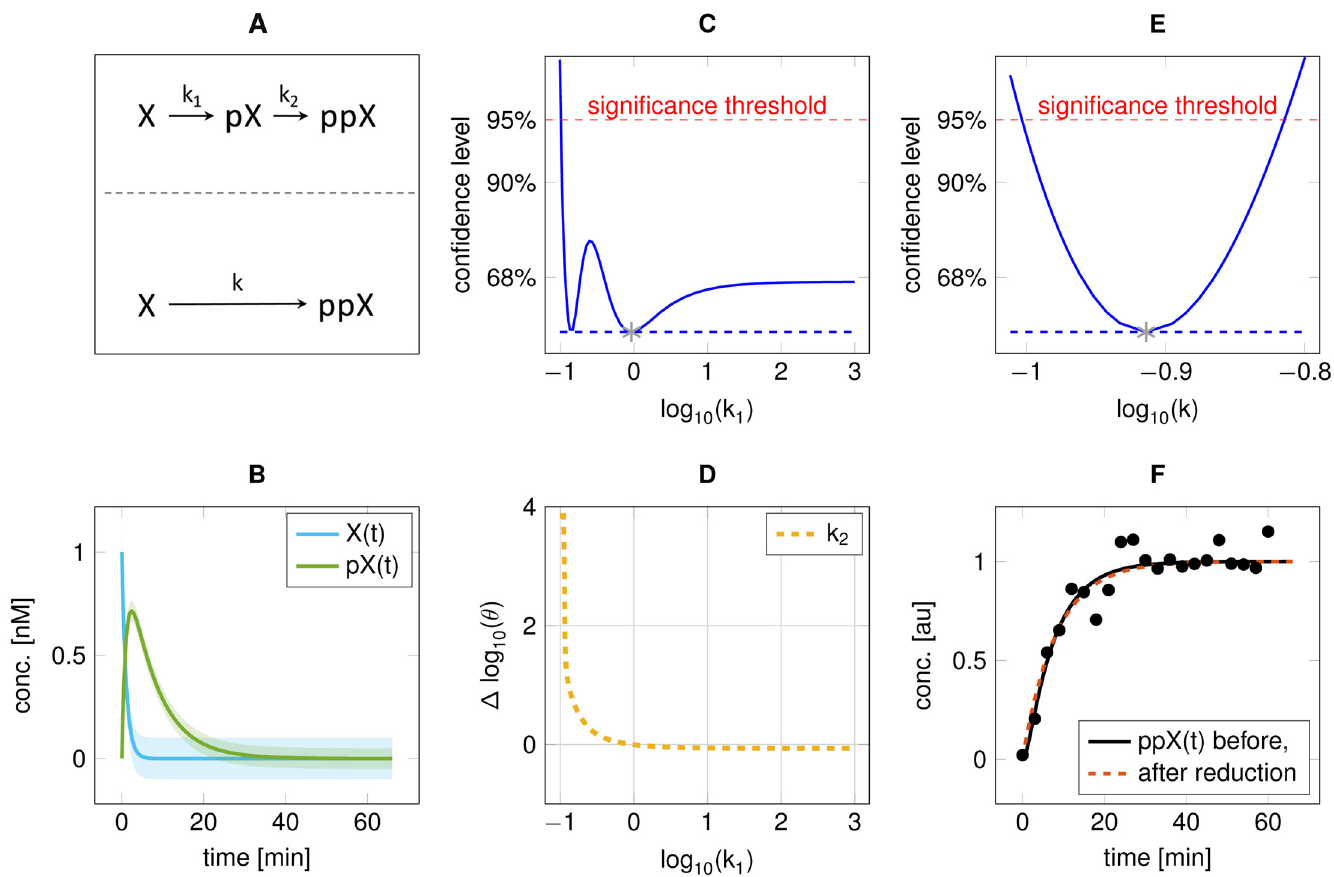
Fig 2. Reduction of the cascade toy model 1 (scenario 1). A: Model scheme before (upper) and after (lower) reduction with lumped states X and pX . B: X ( t ) and pX ( t ) for fitted parameters. C: Profile likelihood for parameter k (panel C). E: Profile likelihood for the identifiable parameter k in the reduced model. F: ppX ( t ) with simulated data after fitting, with comparison between a one and two step conversion.